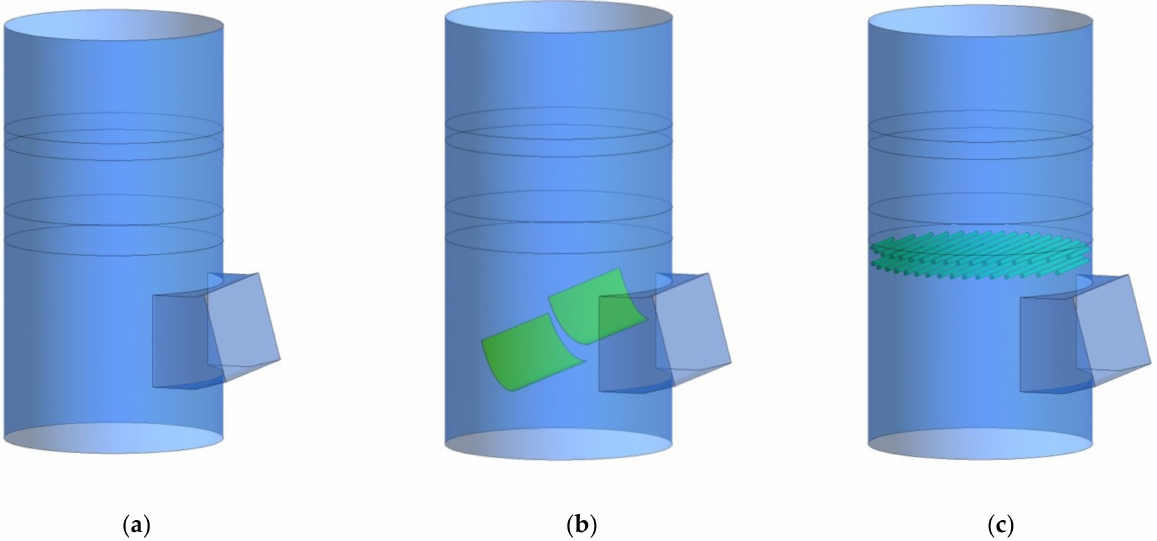
Figure 2. Computational domain: ( a ) OST; ( b ) DST; ( c )